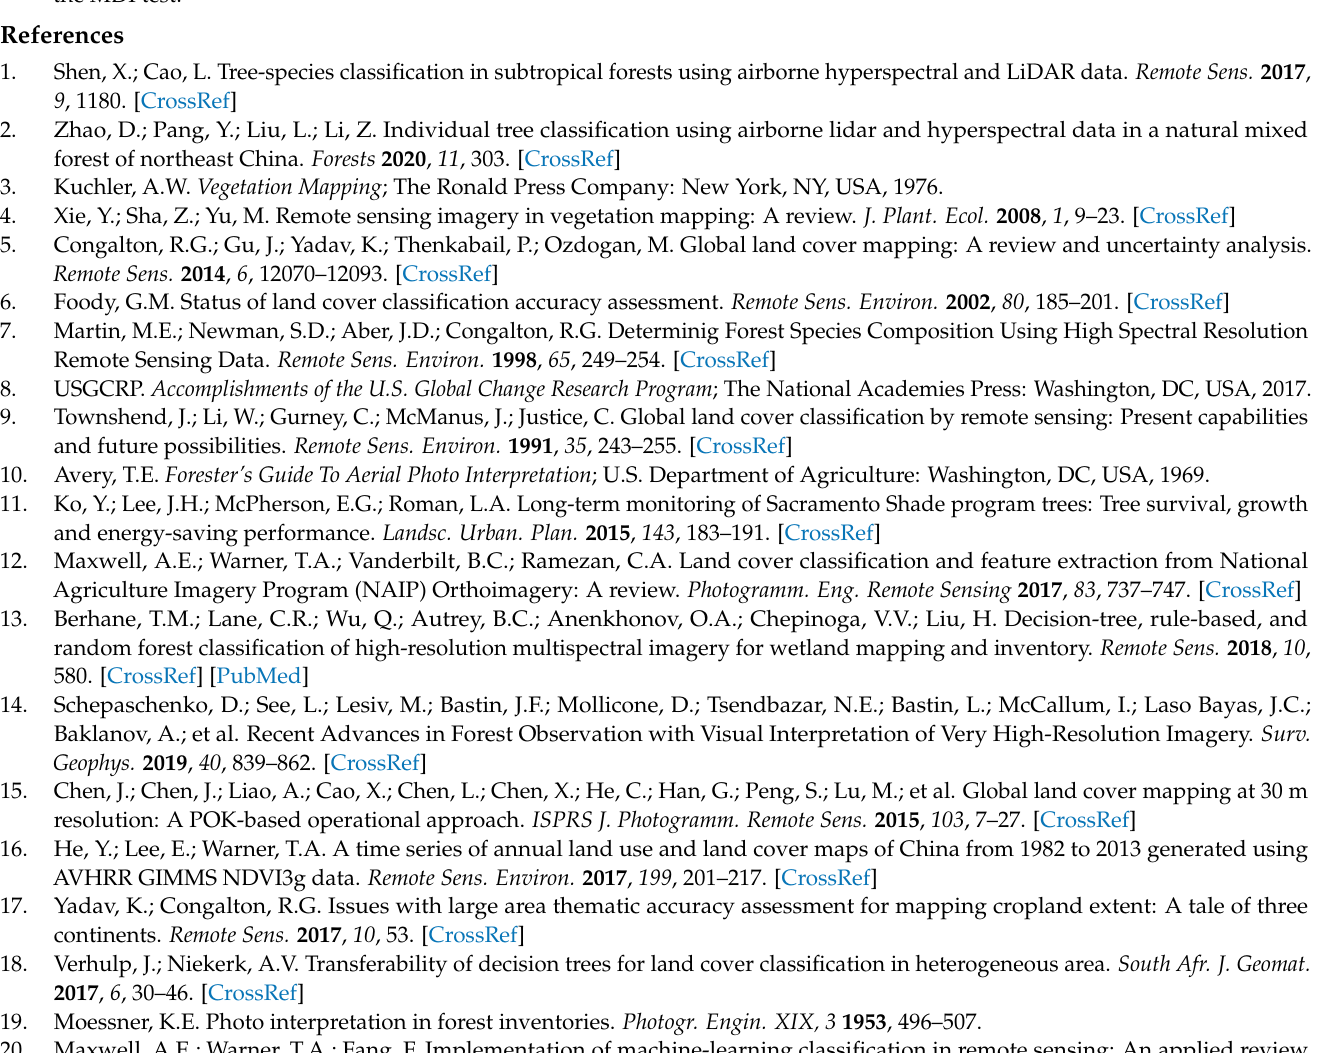
Figure A3. Feature importance for both UAS and NAIP imagery classification of four composition classes calculated using the MDI test.